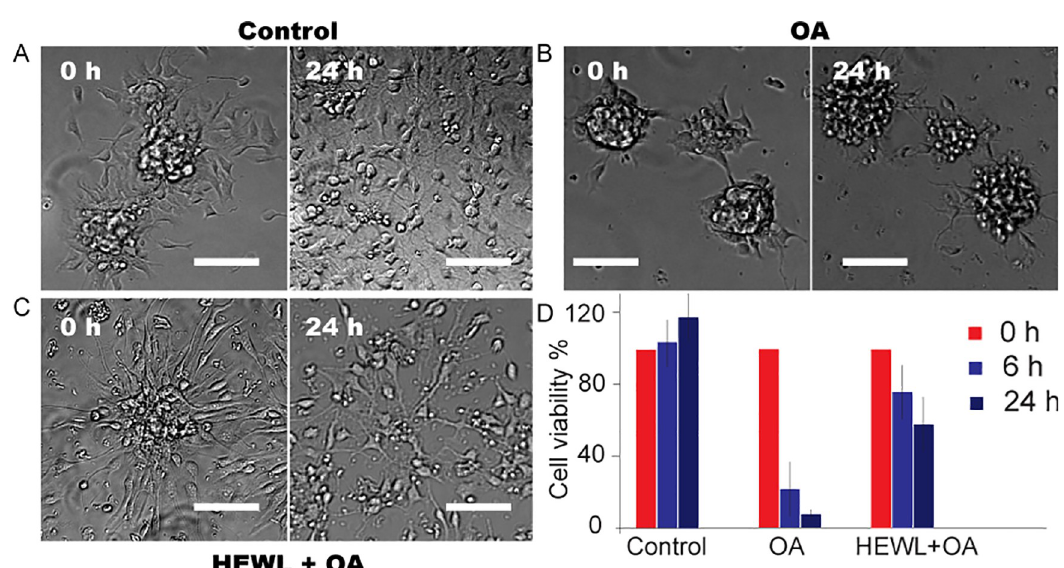
Fig 4. Brightfield images of neural stem cells (NSCs) exposed to (A) culture medium; (B) environmental conditions containing 400 μ M OA; (C) 1.4 mM HEWL with 140 mM OA. Scale bar denotes 100 μ m.The clumps were formed by positioning HEWL and OA mixture (HEWL 1.4 mM and OA140 mM)) under continuous shaking at 800 rpm and 57˚C for 4 d. (D) Measurements of NSCs viability by WST-1 assay in the presence of culture medium, OA and HEWL-OA